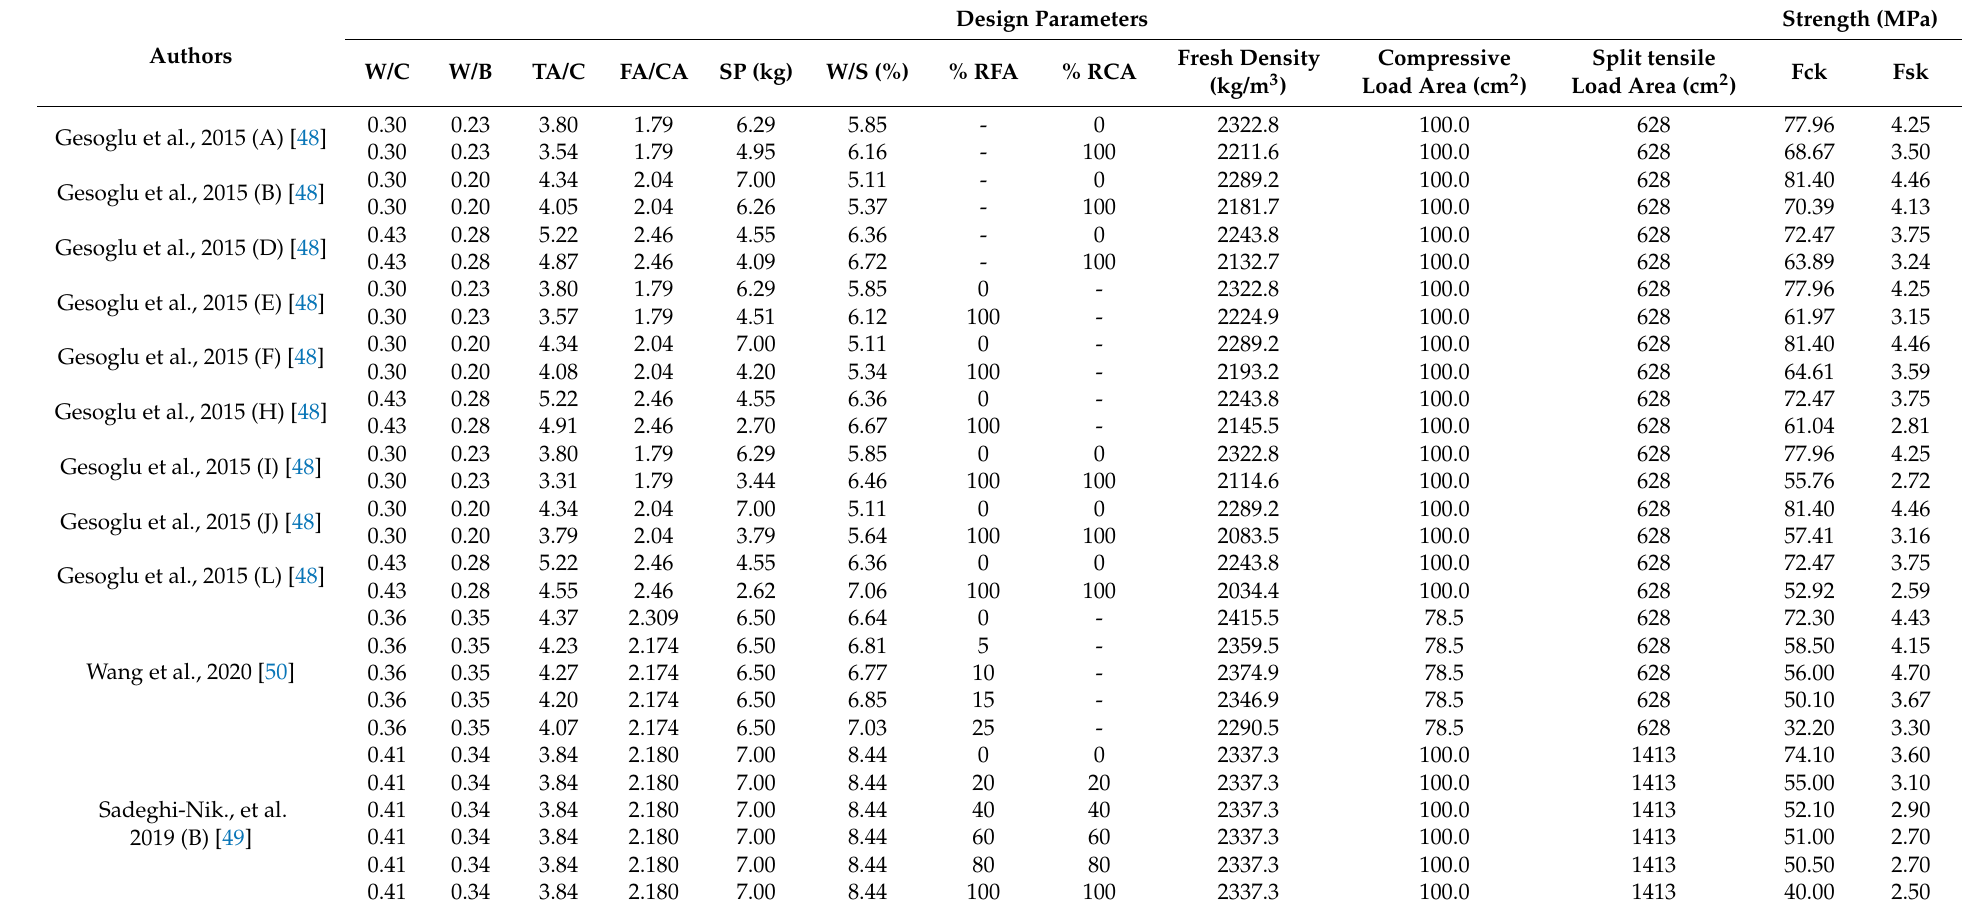
Table 1. Family I (Compressive strength range–70 MPa to 80 MPa) design parameters according to